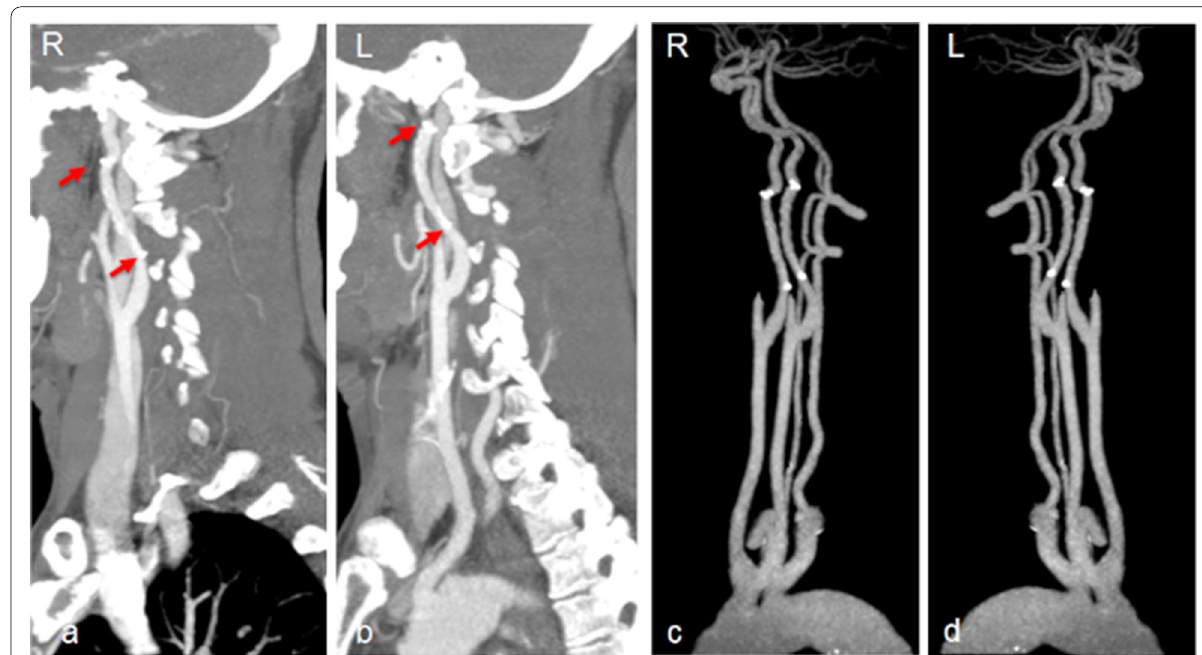
Fig. 3 Follow-up images. a-b Follow-up CTA at three months showed that bilateral ICAs were repaired well (Nov 26, 2020); c-d Follow-up CTA at 15 months showed that bilateral ICAs remained patent and no dissection relapsed (Dec 13,